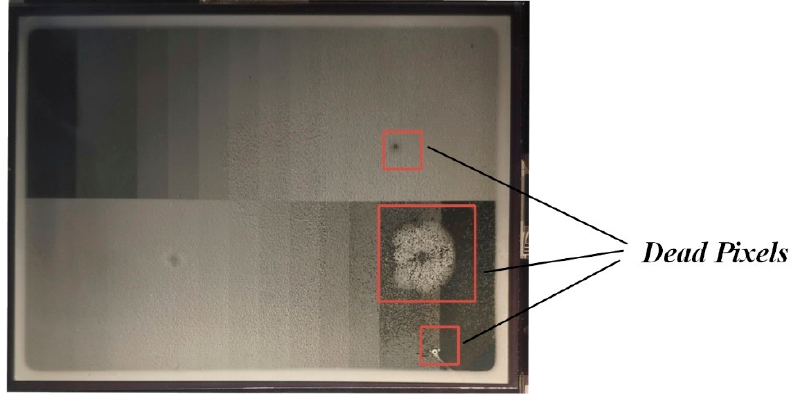
Figure 17. The picture of “Lena” displayed on the EWD, the red rectangles show the difference between the two different waveforms. ( A ) Display with the +15 V DC waveform. ( B ) Display with the proposed multi-DC waveform.